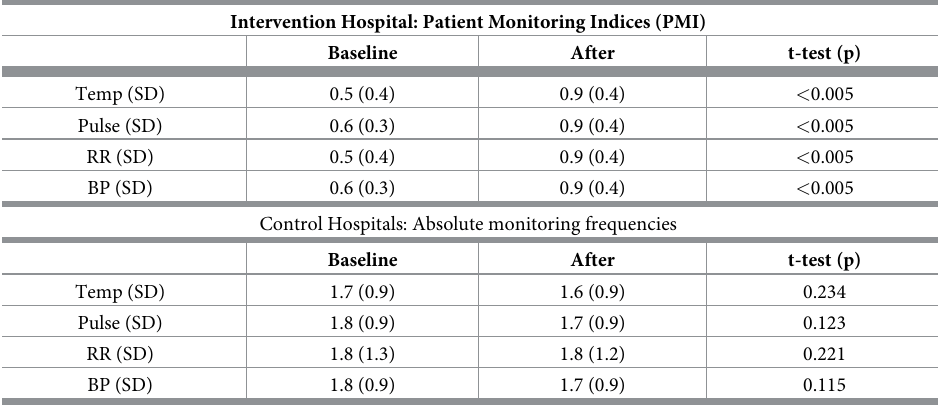
Table 2. Frequency of vital signs monitoring before and after EWS implementation. Intervention Hospital: Patient Monitoring Indices